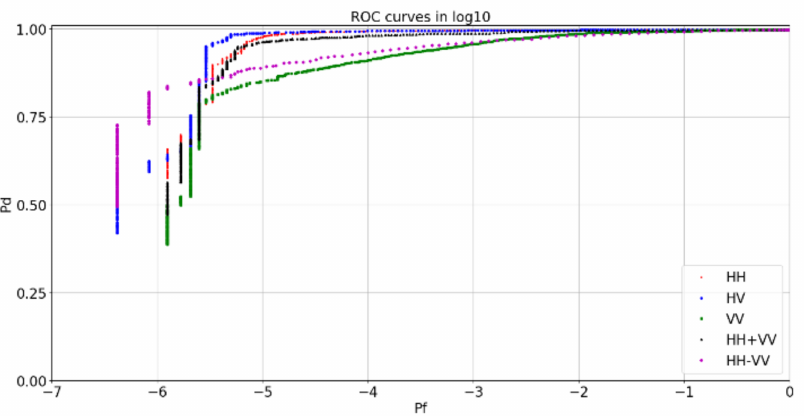
Figure 19. Iceberg detection intensity ROC curves for open ocean, 5 × 5, clutter window size 105 × 105. C11 is a HH polarisation, C22 is a cross-polarised HV polarisation, C33 is a VV polarisation,